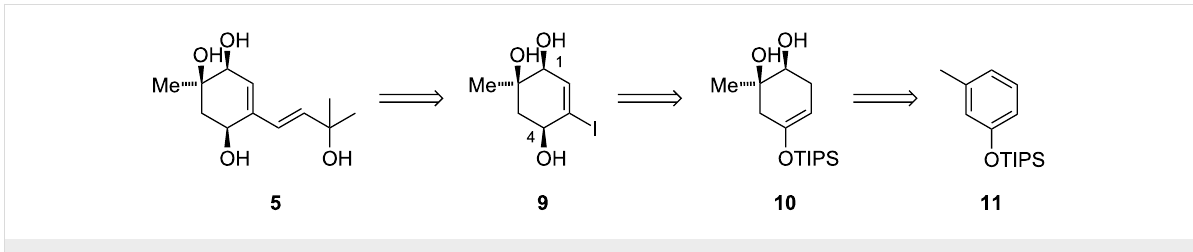
Scheme 1: Retrosynthetic analysis of acremine F ( 5